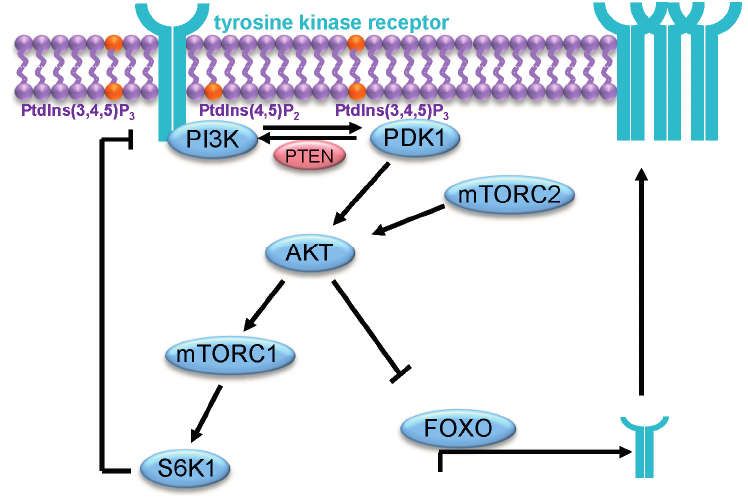
Figure 3. Negative feedback loops in the PI3K/AKT